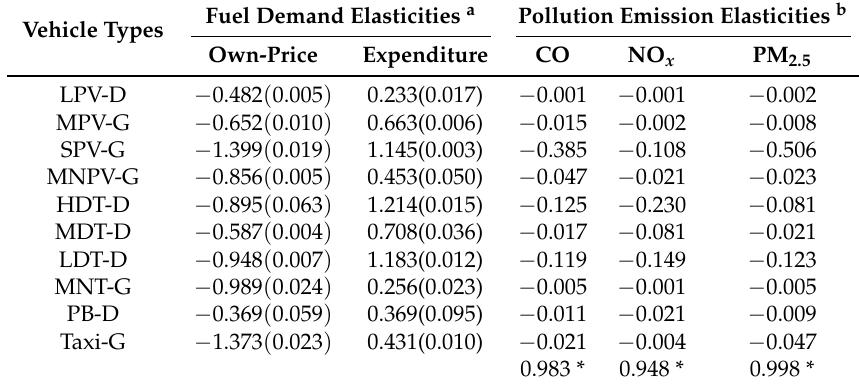
Table 5. Elasticities of fuel demand and air pollution emissions from the QUAIDS model. Vehicle